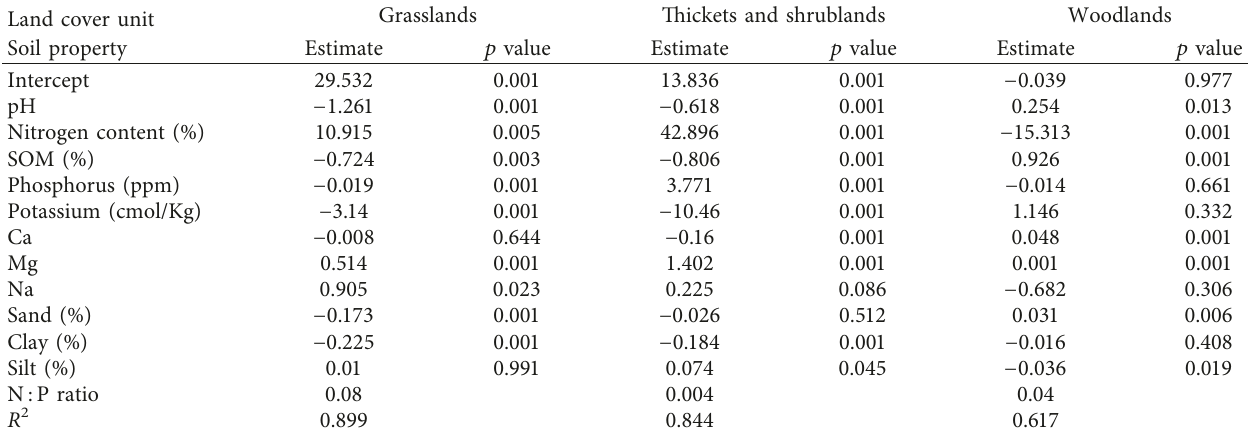
Table 7: Influence of soil properties on forage quantity in the land cover